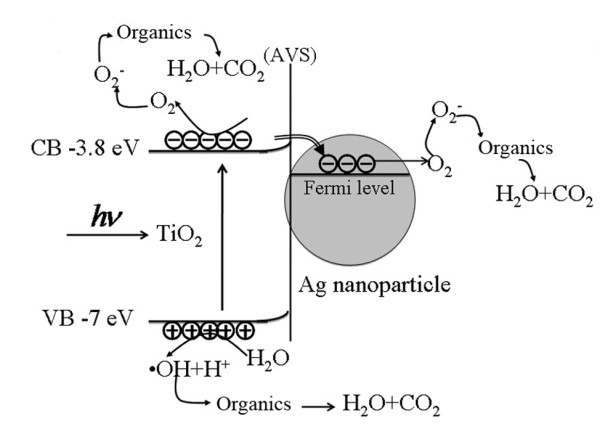
Schematic diagram for the photodegradation of MB by Ag/TiO2nanocomposite system.